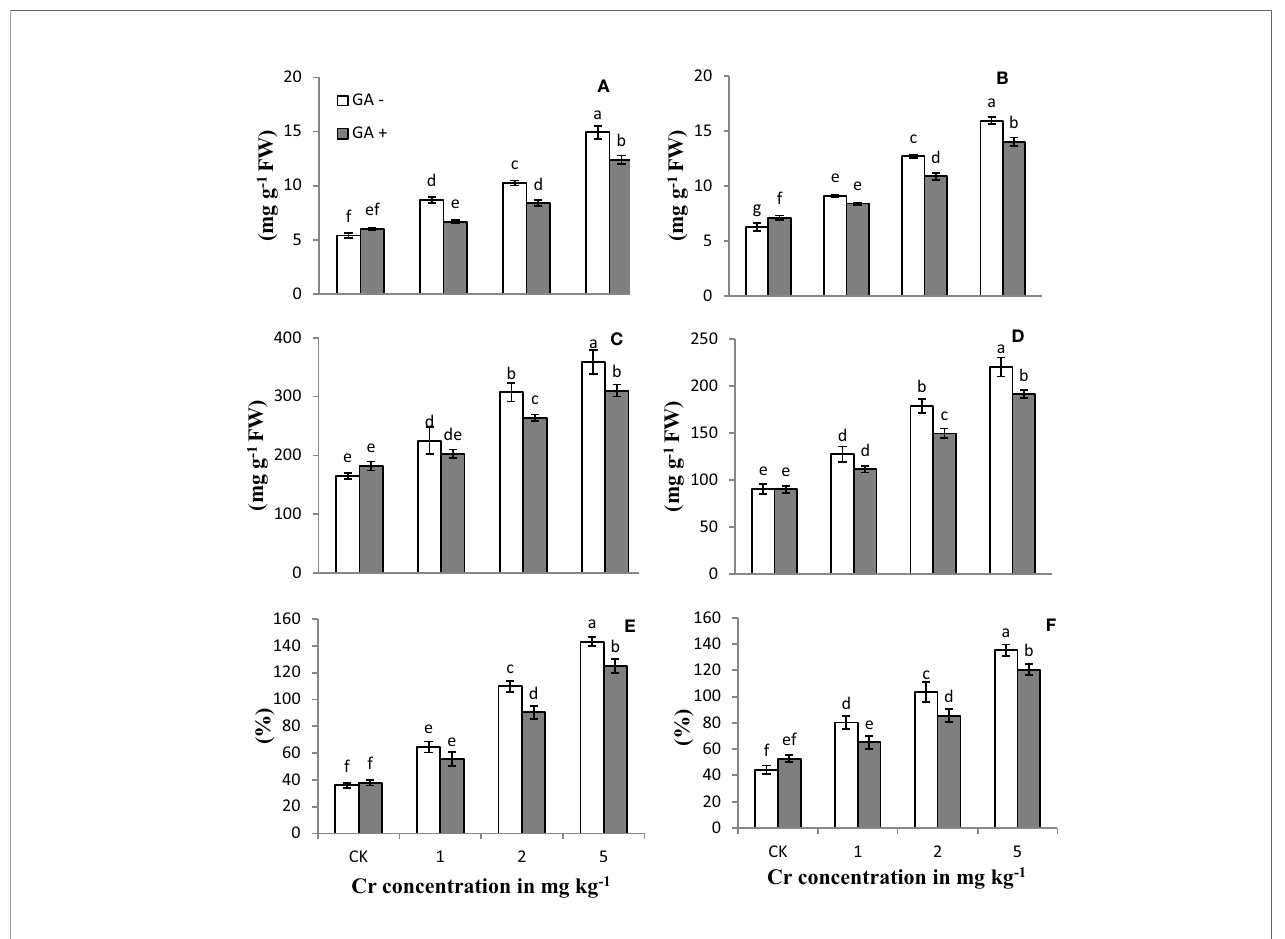
FIGURE 3 | Effect of Cr and GA on MDA in root (A), MDA in leaves (B), H 2 O 2 in root (C), H 2 O 2 in leaves (D), EL in roots (E) and EL in leaves (F) of Sun fl ower grown in soil with increasing Cr concentrations (0, 1, 2 and 5 mg kg -1 ) and GA (0 and 5mM). Values are demonstrated as means of fi ve replicates along with standard deviation. Different small letters indicate that values are signi fi cantly different at P<0.05